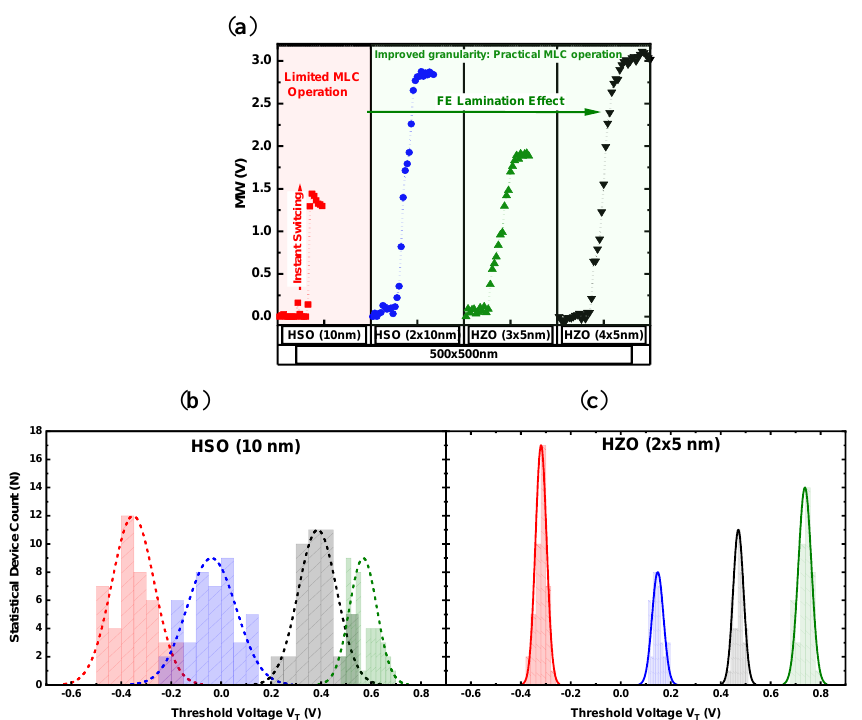
Figure 14. The role of ferroelectric stack lamination on ( a ) MW switching with a transition from instant to gradual switching, ( b – c ) 2 bit/cell levels for HSO (10 nm) and HZO (2 × 5 nm) illustrating narrower distributions for the HZO laminate stack; ( a – c ) indicates improved film granularity and lower variability induced by lamination. Reproduced with permission from [17] T. Ali et al., IEDM; published by IEEE, Copyright 2019, IEEE.